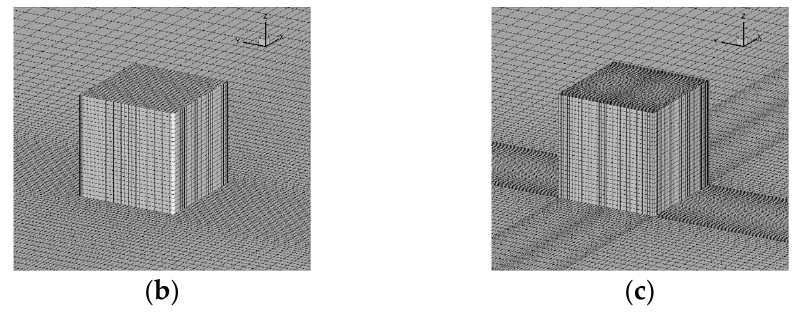
Figure 3. Computational grids: ( a ) coarse mesh, 231,400 hexahedral cells with the minimum size being 0.05 H (y + = 250); ( b ) basic mesh, 789,725 hexahedral cells with the minimum size being 0.04 H (y + = 200); ( c ) fine mesh, 2,264,744 hexahedral cells with the minimum size being 0.015 H (y + = 75).